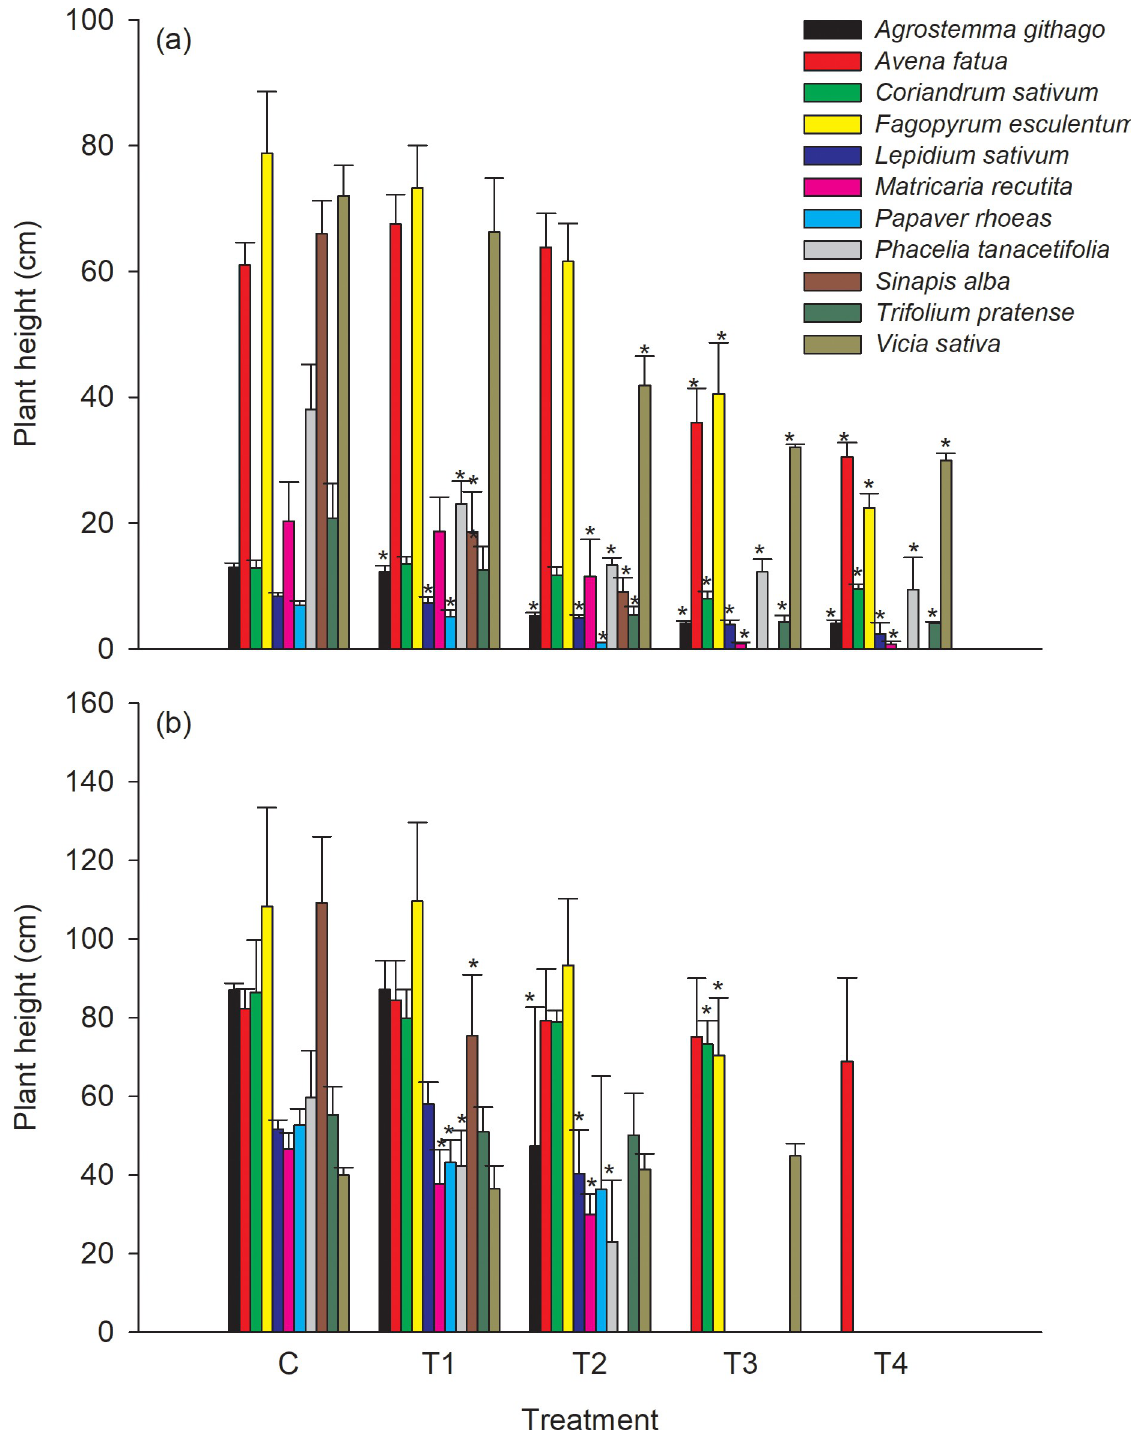
Fig 2. Mean plant height at the vegetative (21 DAA, (a)) and generative (BBCH 89, (b)) growth stage of the test plants, respectively. Error bars indicate the standard deviation and � indicate a statistical significant difference to the control (William‘s test or Multiple Welch‘s t-test with Bonferroni-Holm adjustment depending on homoscedasticity) for each plant species ( α = 0.05, one sided). Missing columns within a treatment group indicates that no data could be assessed for the respective plant species.